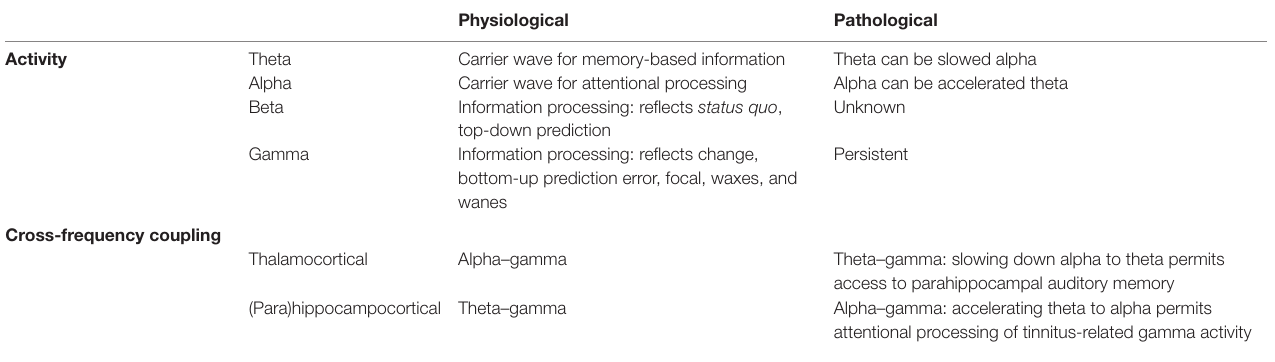
TABle 1 | Summary of physiological and pathological oscillatory activity and cross-frequency